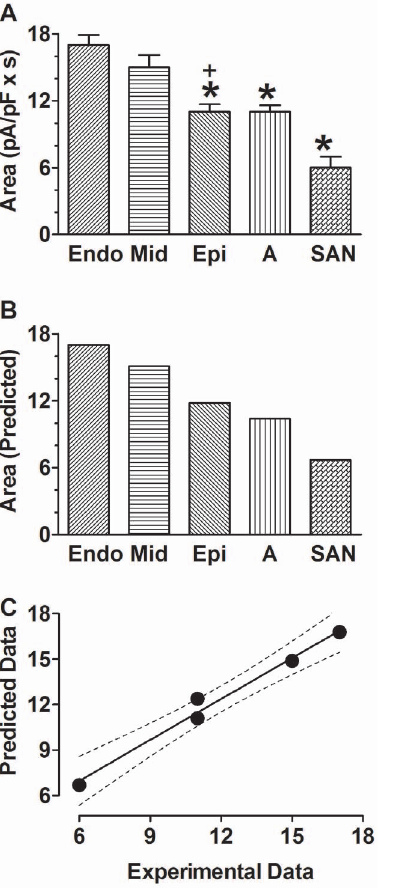
Figure 7. Spatial and transmural heterogeneity of HERG K + channel function. A , Experimental data of the area under I HERG trace, a quantitative index of the size of current flow through HERG channels during action potentials. * p , 0.05 vs. Endo; + p , 0.05 F-test (ANOVA) for transmural difference. B , Theoretical (Predicted) data of the area under I HERG trace. C , Correlation between experimental data and predicted data. The solid line represents the linear regression to the data points and the dotted lines indicate 95% confidence.